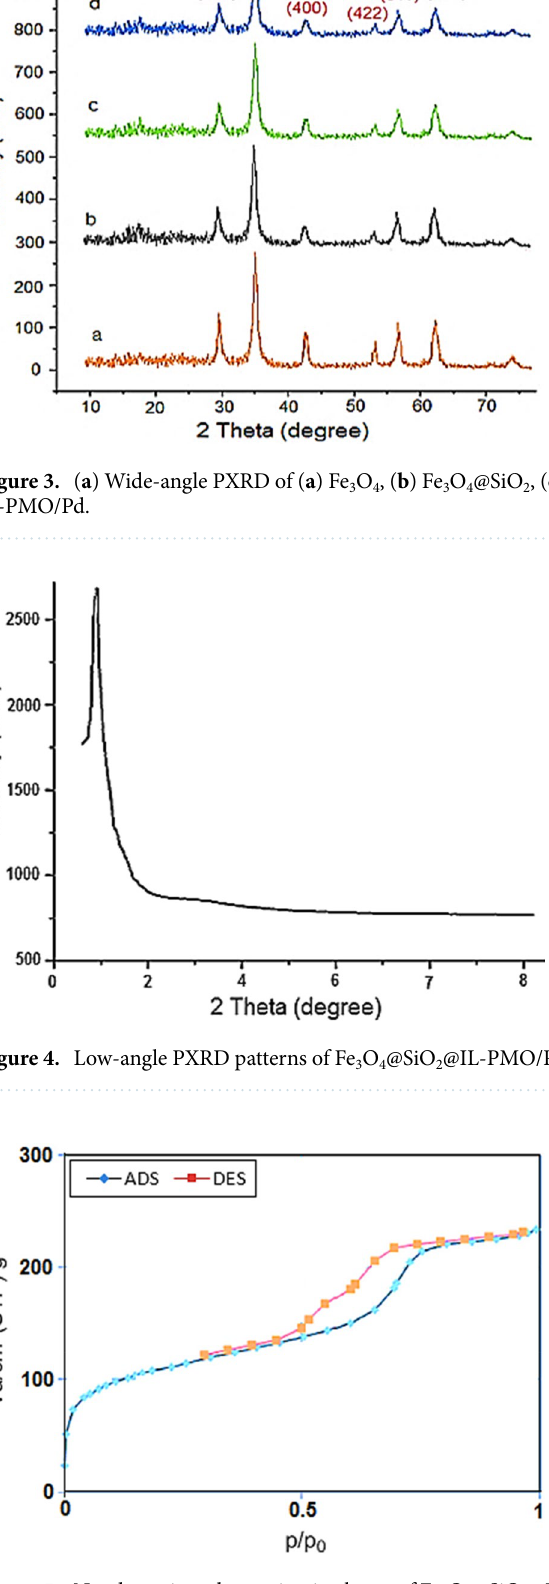
Figure 5. N 2 adsorption–desorption isotherm of Fe 3 O 4 @SiO 2